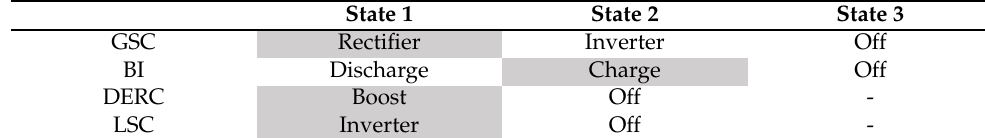
Table 4. Modes of